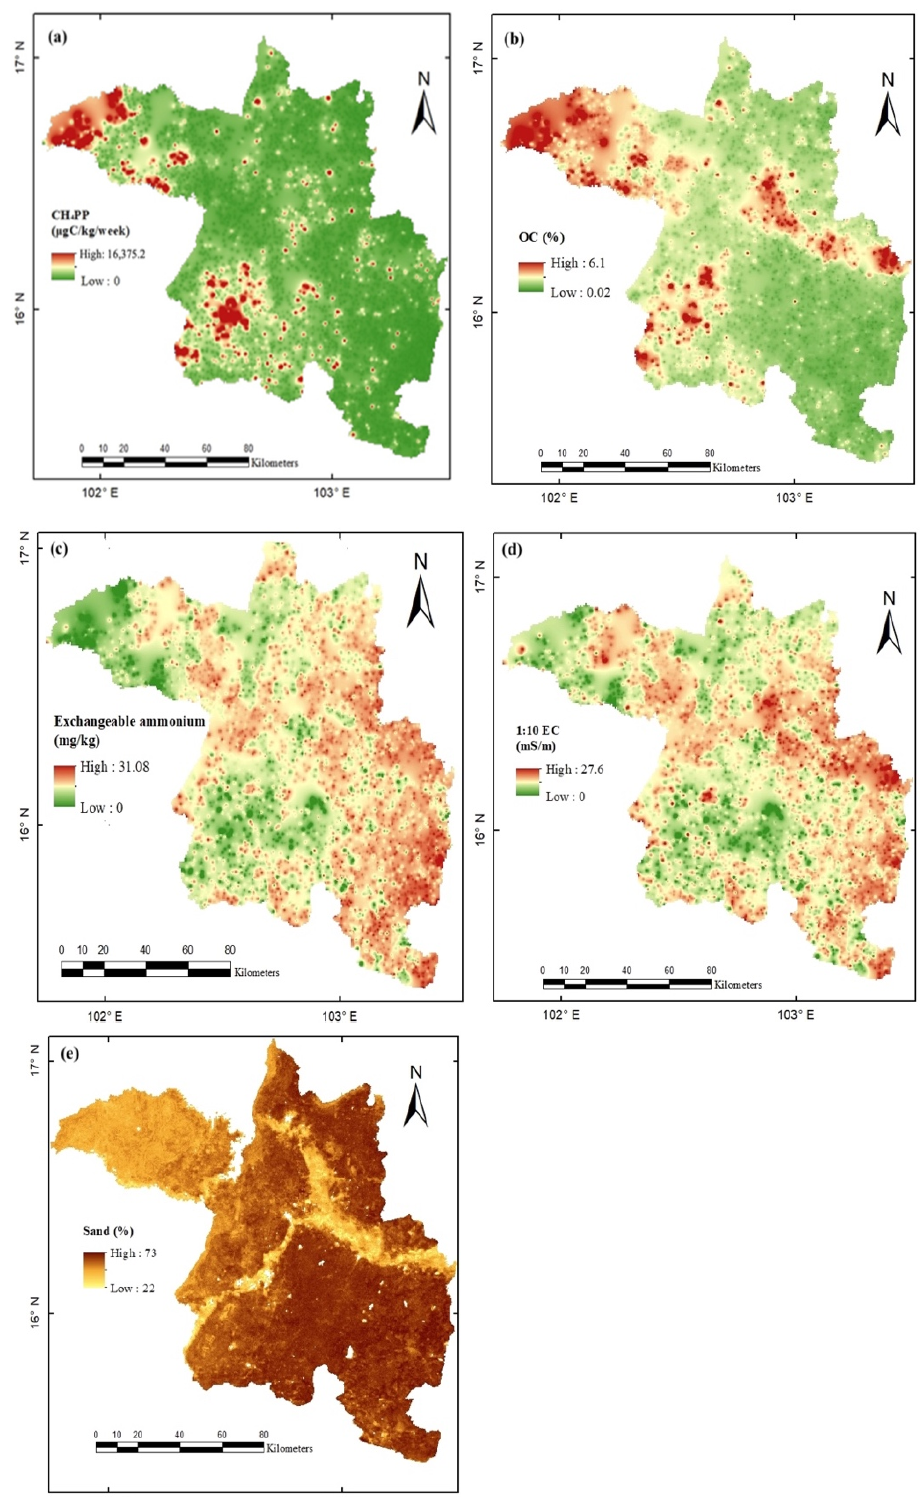
Figure 7. Spatial map of predicted CH 4 production potential ( a ), soil organic carbon ( b ), predicted exchangeable ammonium ( c ), 1:10 predicted electrical conductivity ( d ), and sand content ( e ) in Khonkaen province.